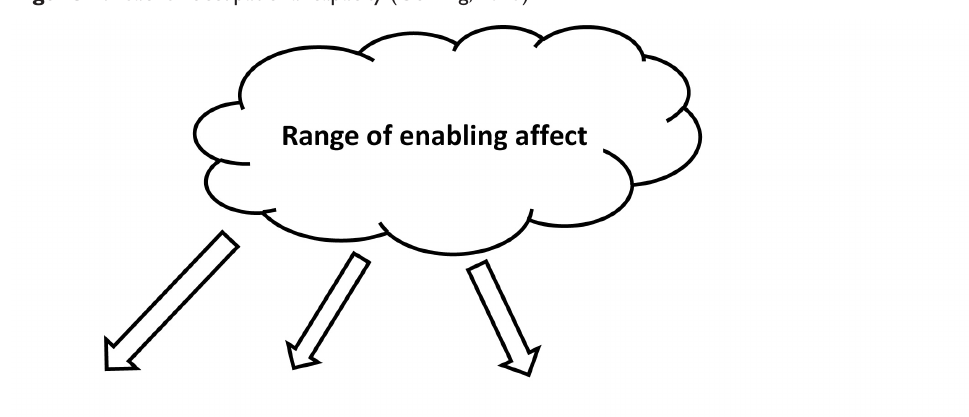
Figure 1: Teacher occupational capacity (Golding,